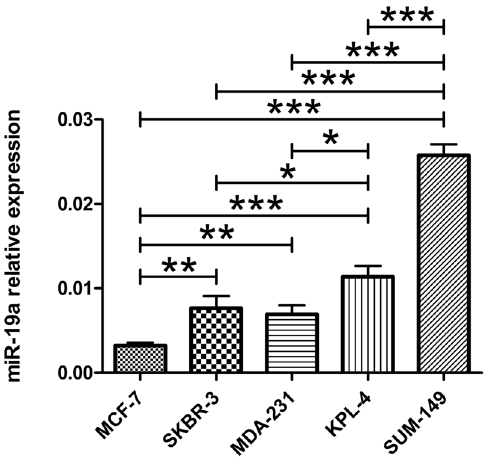
Figure 4. MiR-19a expression in breast cancer cell lines. The expression of miR-19a was evaluated in 5 breast cancer cell lines. The two IBC cell lines SUM-149 (TN) and KPL-4 (HER2 + ) expressed significantly higher levels of miR-19a than the non-IBC cell lines MCF- 7 (ER + ), SKBR-3 (HER2 + ), and MDA-231 (TN) (mean 6 standard deviation; 2-tailed Student’s t- test; p , 0.05 is indicated with: *; p , 0.01 is indicated with: **; p , 0.001 is indicated with: ***).